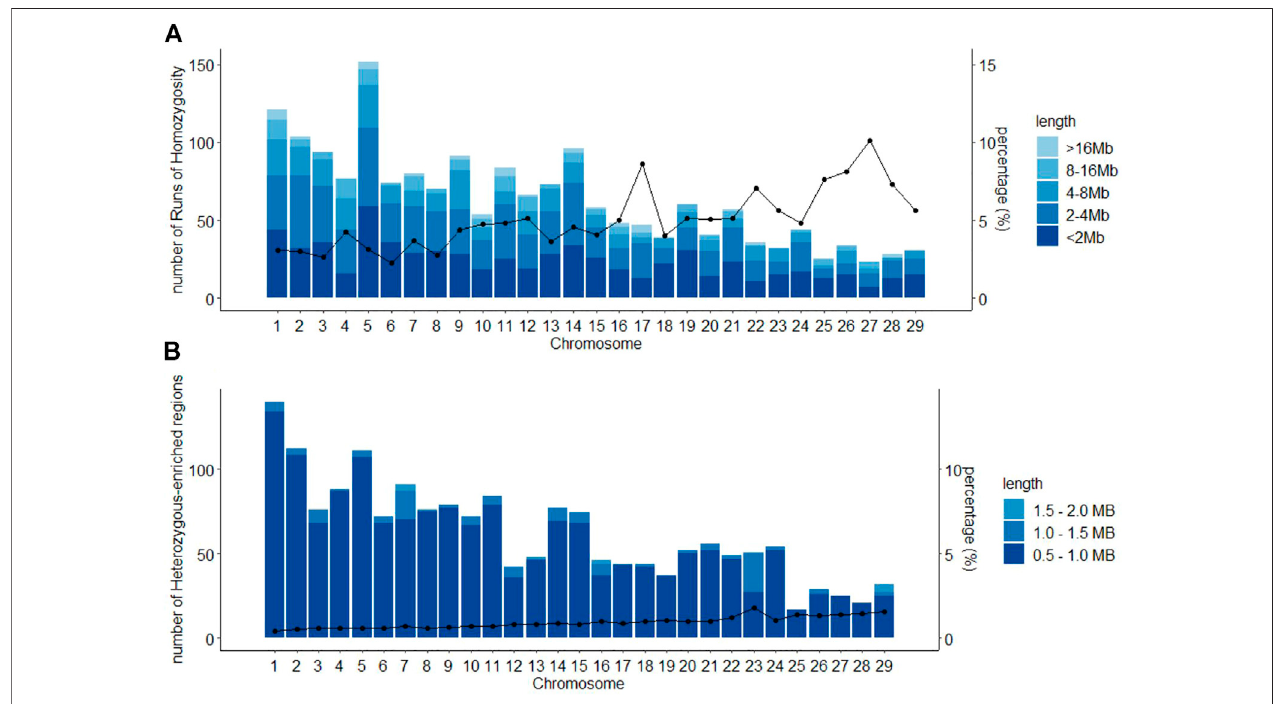
FIGURE 4 | Classi fi cation of runs of homozygosity ROH (A) and heterozygous-enriched regions HER (B) , by chromosome, according to the length size in the Purunã breed, and the average percentage of chromosome covered by ROHs/HERs.